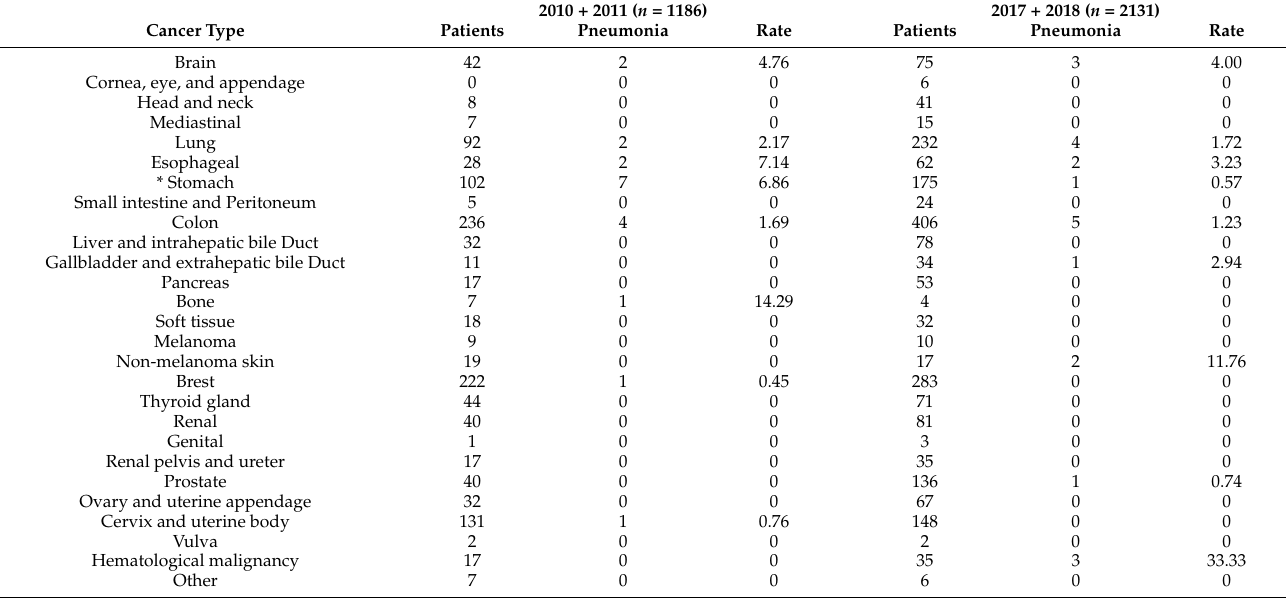
Table 4. Comparison of the incidence of pneumonia based on cancer type. The incidence of postoperative pneumonia was decreased in patients with cancers of the digestive organs, such as the stomach, esophagus, and colon, and of the lung, brain, bone, and uterus, as a result, but only in gastric cancer surgery had a significant difference in